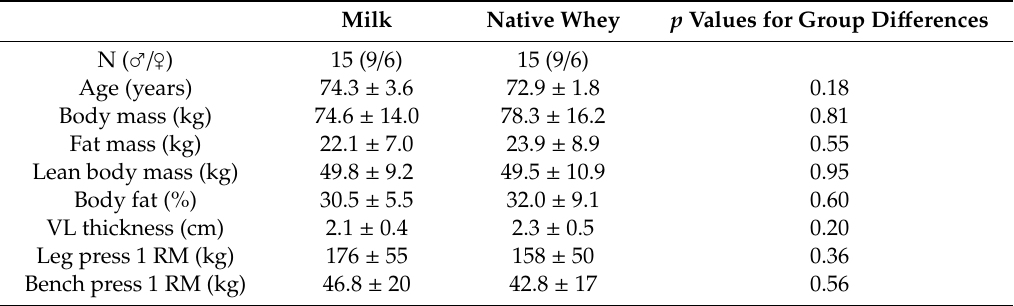
Table 2. Participants characteristics. Milk Native Whey p Values for Group Di ff